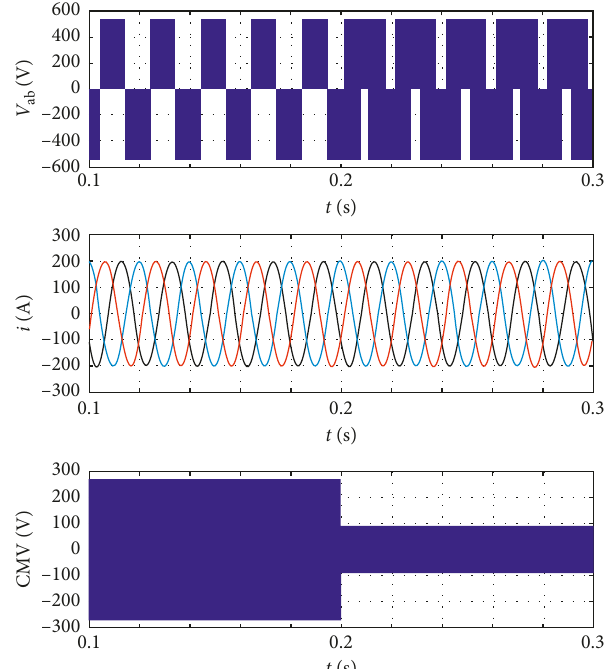
Figure 11: Comparison results between the MPC method with constant switching frequency in [27] and the proposed